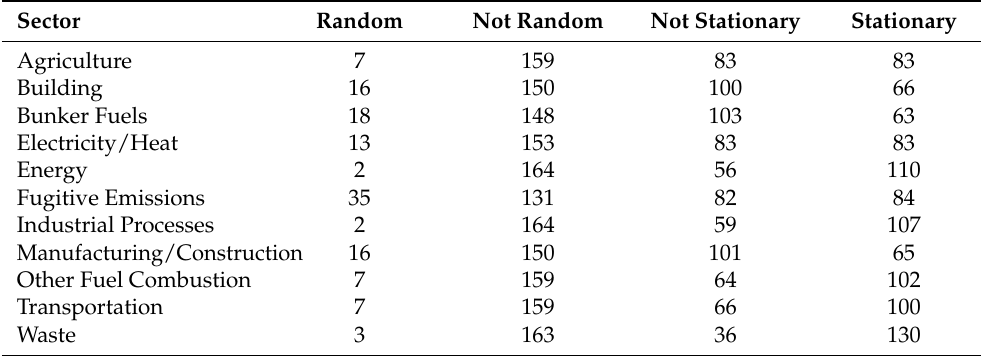
Table 1. The number of countries where the GHG emission-related time series of a given sector show random or stationary